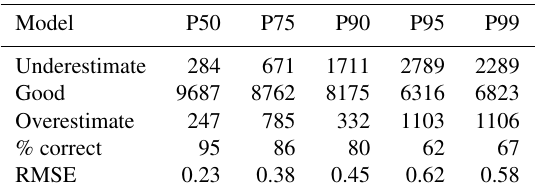
Table 6. Number of pixels where the HEI obtained through the LCZ– T model (Fig. 11) underestimates, overestimates or coincides with the HEI provided by the urban climate model (Fig. 6) for the different scenarios. Percentage of coincidences and RMSE are also